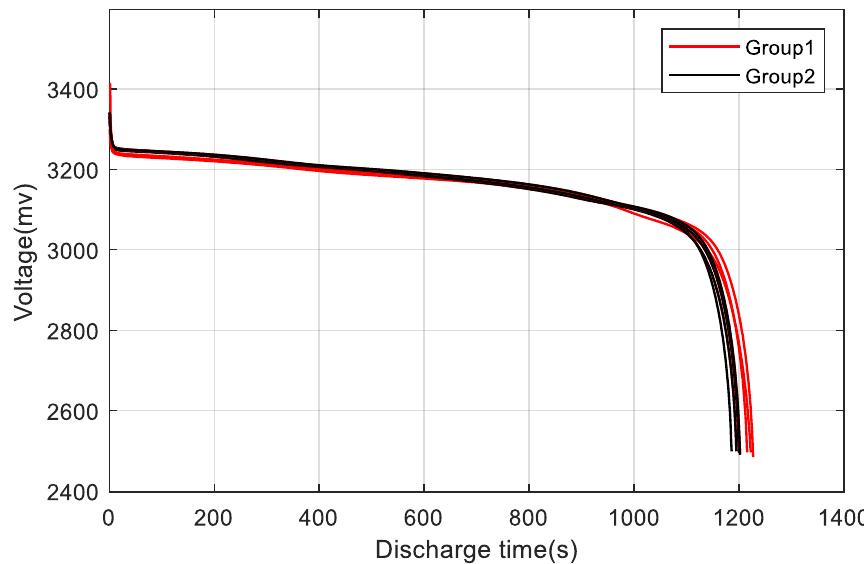
Figure 5. The discharge curve of the battery that meets the sorting conditions.